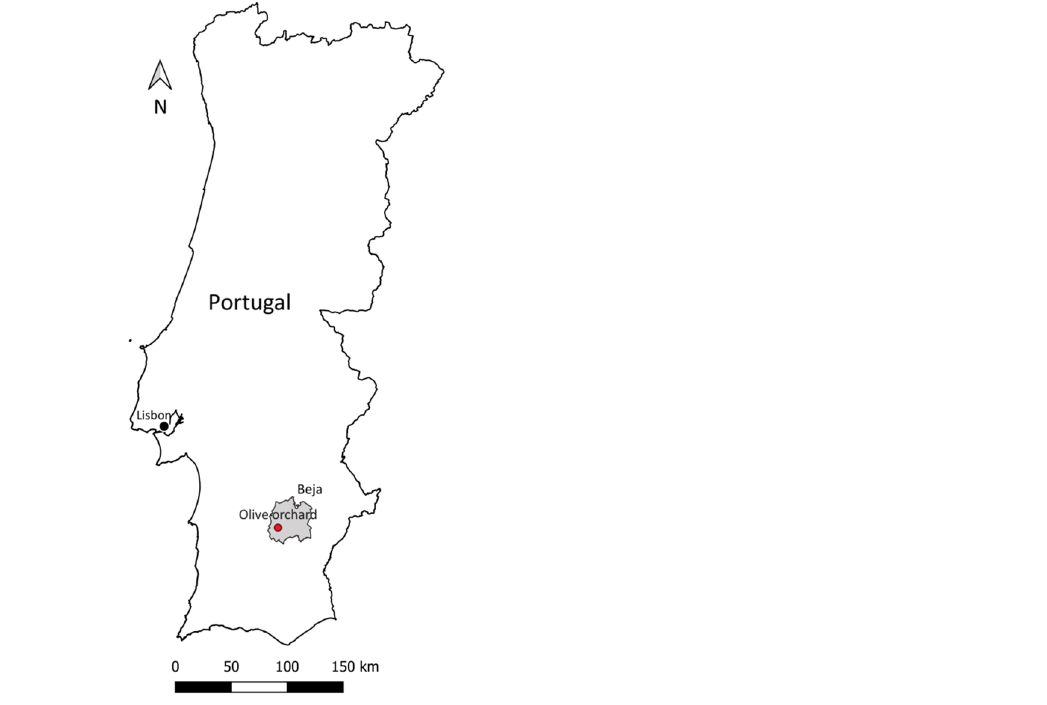
Figure 1. Location of the study area in the Beja municipality in the south of Portugal.